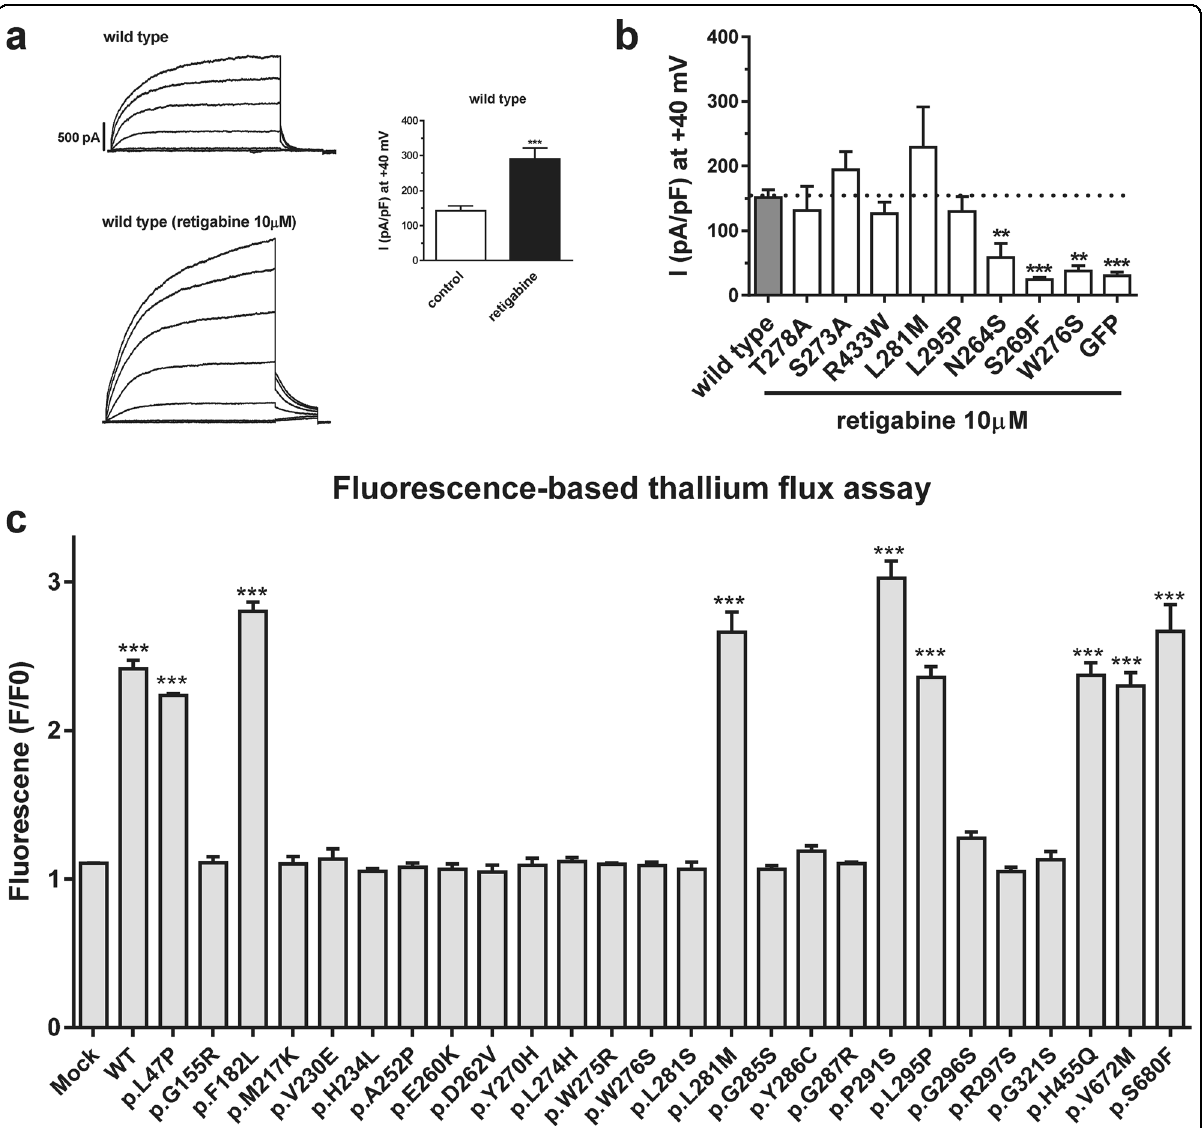
Fig. 4 Effect of retigabine on current produced by KCNQ4 mutants. a Enhancement of voltage-gated potassium channel activity of wild-type (WT) KCNQ4 by retigabine. b Summary bar graph of current produced by KCNQ4 mutants and rescued by retigabine versus that of WT, obtained from steady-state currents elicited at 40 mV shown in Supplementary Fig. 2. Current values were 131.4 ± 37.6 pA/pF ( n = 11), 194 ± 28.3 pA/pF ( n = 9), 229.2± 62.2 pA/pF ( n = 6), 129.7 ± 23.2 pA/pF ( n = 8), 126.4 ± 17.8 pA/pF ( n = 10), 58.8 ± 21.5 pA/pF ( n = 6), 24.4 ± 3.3 pA/pF ( n = 4), 37.4 ± 8.6 pA/pF ( n = 4), and 30.4 ± 5.8 pA/pF ( n = 5) for p.T278A, p.S273A, p.L281M, p.L295P, p.R433W, p.N264S, p.S269F, p.W276S, and green fl uorescent protein, respectively. c Effect of retigabine on thallium in fl ux in cells expressing WT and mutant KCNQ4. Data represent the mean ± SEM. ** P < 0.01, *** P < 0.001 compared to WT ( a , b ) or mock ( c ). Statistical analysis was performed using one-way ANOVA with Bonferroni ’ s multiple